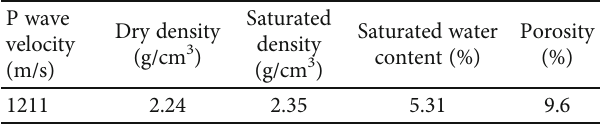
Table 1: Physical properties of the studied red sandstone. P wave